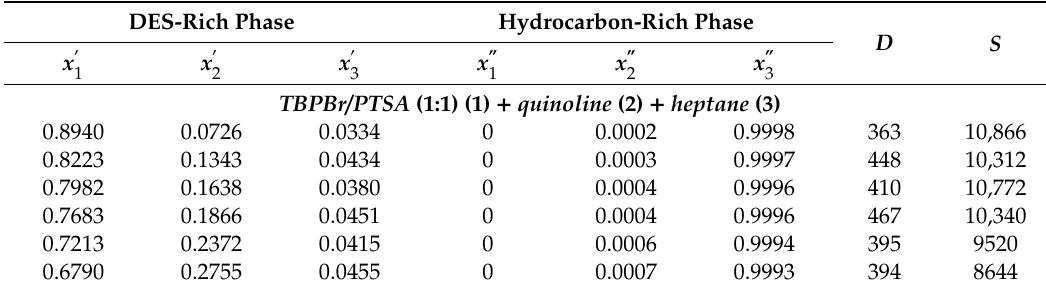
Table 4. Compositional analysis for systems containing quinoline, heptane, and DES TBPBr / PTSA (1:1) at room temperature along with distribution ratio, D , and selectivity, S